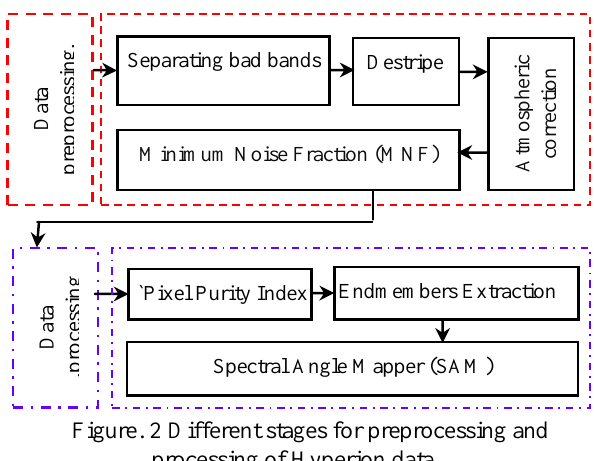
Figure. 2 Different stages for preprocessing and